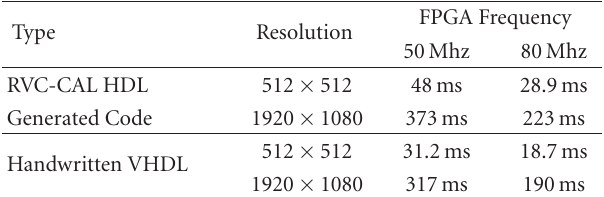
Table 3: RVC-CAL JPEG encoder throughput for one image in